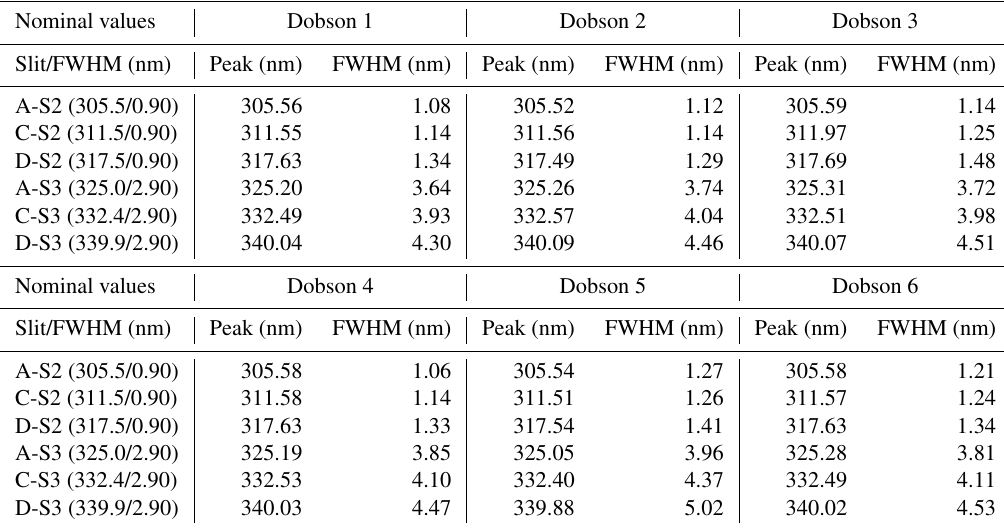
Table 2. Results of the TuPS-based in-field characterisations of different Dobsons which were measured during the campaign in El Arenosillo in September 2017.